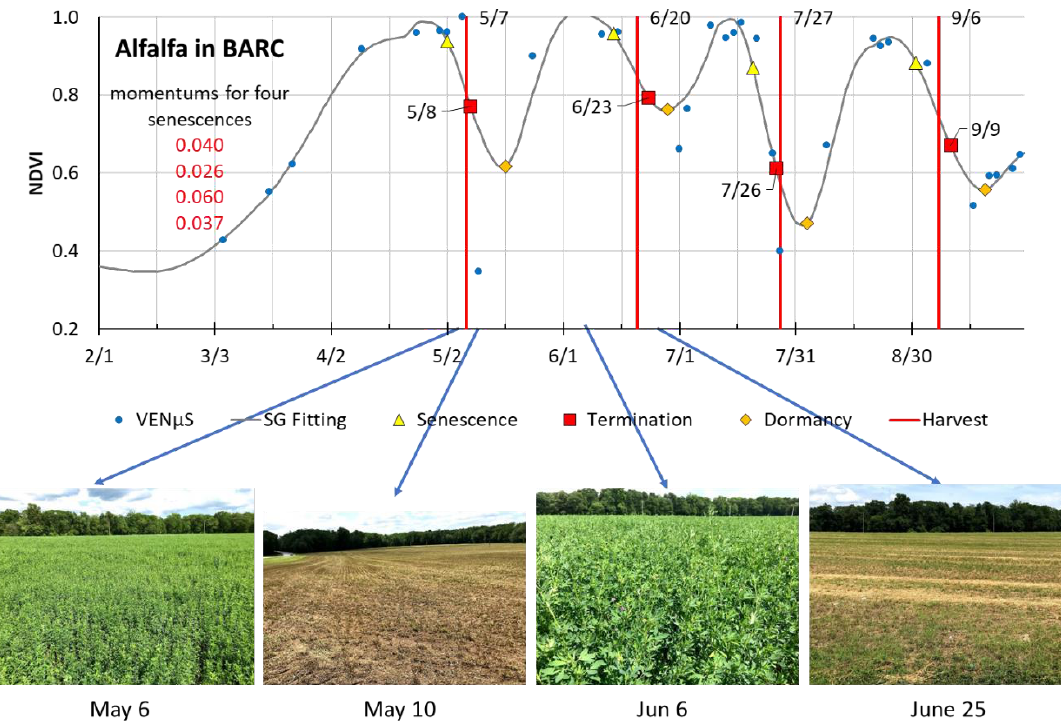
Figure 5. Four terminations were detected for an alfalfa pixel (39.0210° N, 76.8467° W) in field #5-9 at the BARC using the VENµS NDVI time-series in 2019. All downward trends were significant, and the detected termination dates were close to the recorded harvest dates (vertical red lines).